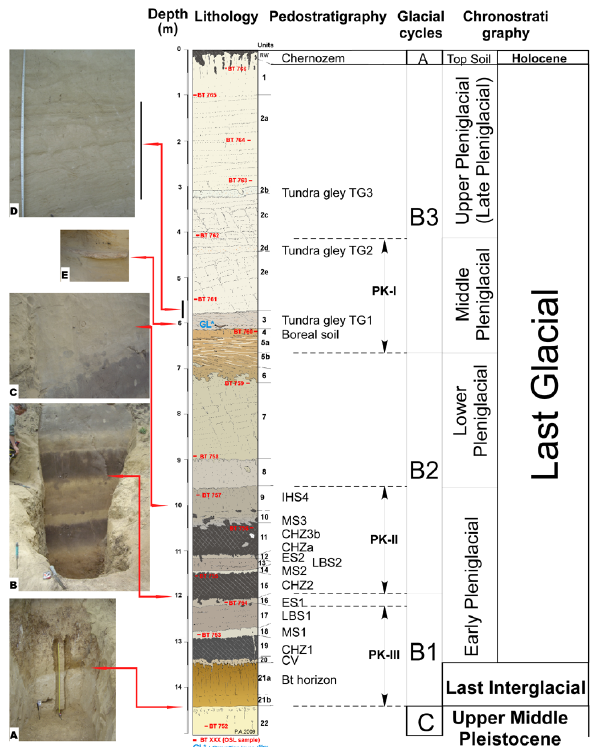
Fig. 3. Stratigraphy of the last climate cycle at Dolni Veston- ice (DV), Czech Republic adapted from Antoine et al. (2013). On the right is the chronostratigraphy, in terms of glaciation cy- cles; in the middle is the pedostratigraphy, with the lithological succession of the soil complexes PK=I, II, and III, according to Kukla (1961); and on the left are given visual snapshots of the se- quence: (A) penultimate climate cycle (Saalian loess) and the inter- glacial Bt paleosol horizon; (B) PKIII and PKII soil complex suc- cession; (C) irregular top of the upper chernozem of the PKII soil complex; (D) Mammoth bone in the Gravetian layer, showing evi- dence of charcoal; and (E) sandy loess, showing wedges. Litholog- ical log by P. Antoine, in Fuchs et al. (2013), photos DDR. Legend: Bt – Bt paleosol horizon; CV – colluvium; CHZ – chernozems; LBS –“Lehmbröckelsände” (or Pellet Sands); MS – “marker silt”; ES – “eolian silt”; IHS: isohumic soil horizon. The labeling of these units respect the original one from Kukla et al and therefore differs from the one used by Antoine et al. (2013) except for